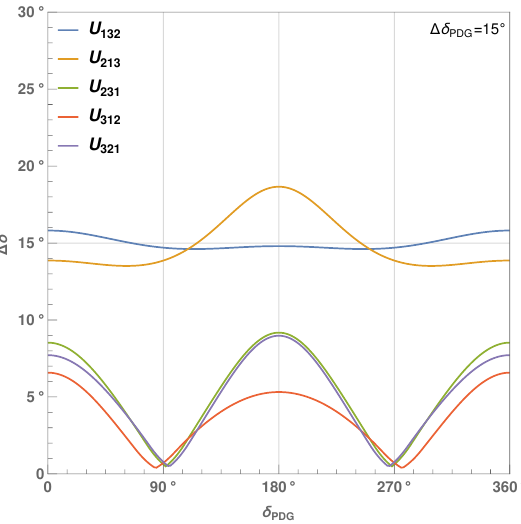
Figure 5 . Uncertainty of the CP-violating phase of alternate parameterizations of the neutrino mixing matrix ( δ 0 ) as a function of δ